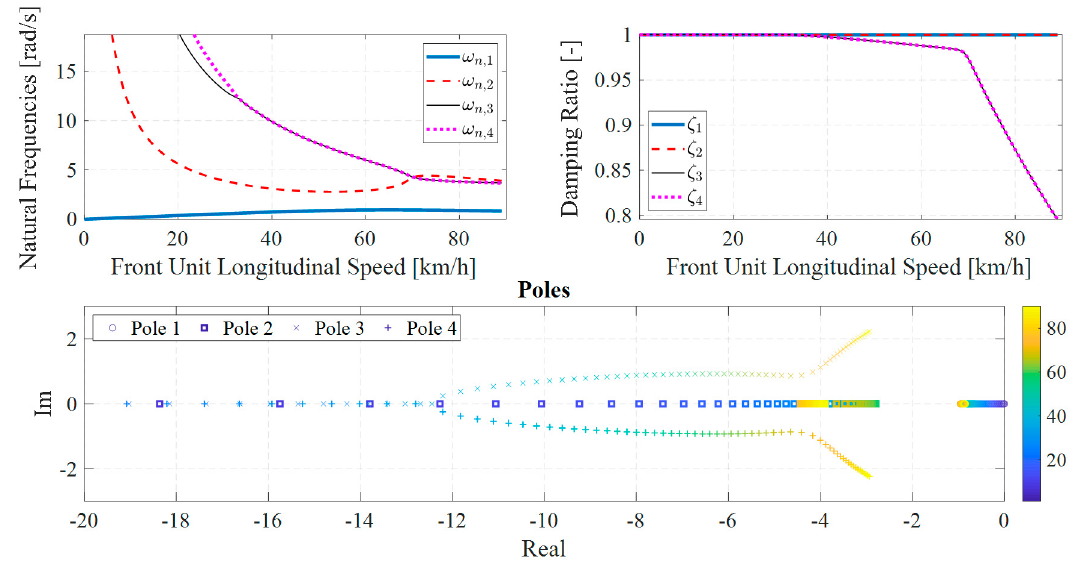
Figure 9. Natural frequencies ω n , i , damping ratio ζ i and poles of the ATV linear model as functions of vehicle longitudinal speed u 1